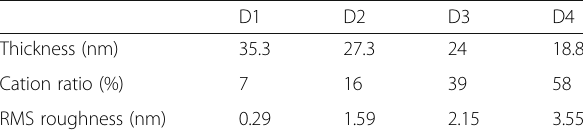
Table 1 Thickness, cation atomic ratio, and roughness of the fabricated devices